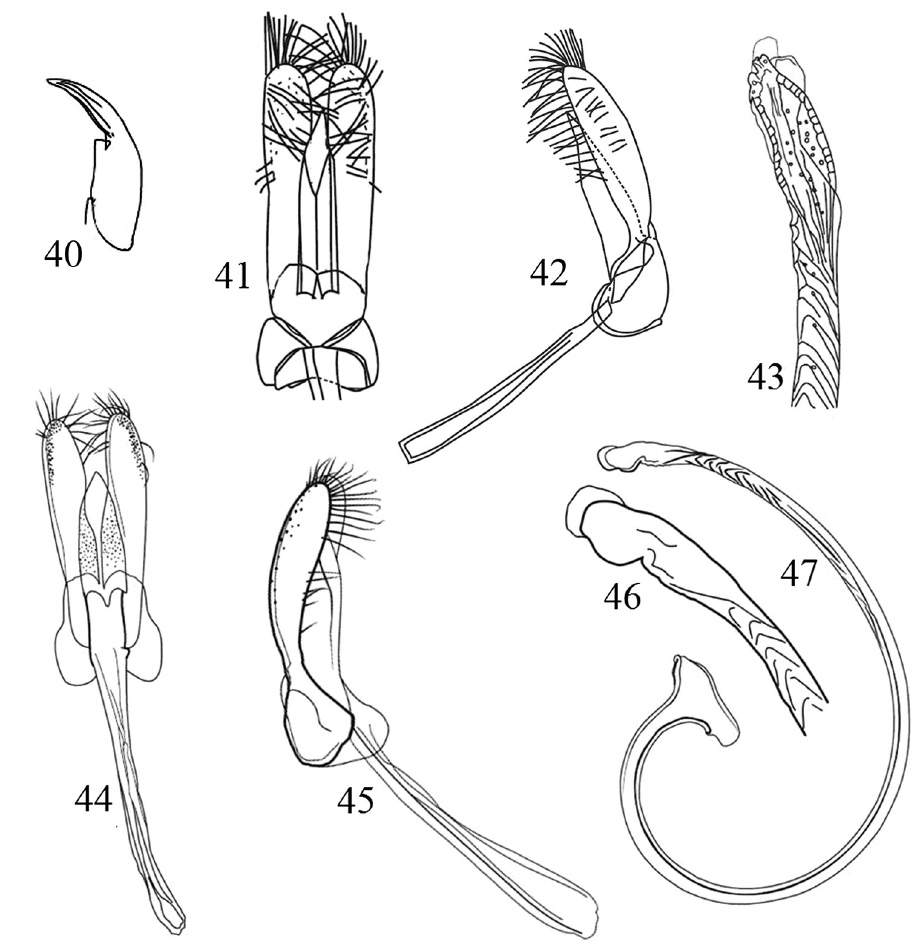
Distribution in Iran. Golestan (Montazeri and Mossadegh1995), Lorestan (Jafari and Kamali 2007), Gilan (Hajizadeh et al. 2003), Fars, Kerman, Khorasan, Khuzestan, Sistan, and Baluchestan (Moddarres-Awal 2012), Lorestan (current study). Ecology. This species feeds usually on the following hemipterans: Acanthococcus abaii (Eriococcidae), Agonoscena pistaciae (Psyllidae), Bemisia tabaci (Aleyrodidae) (Moddarres-Awal